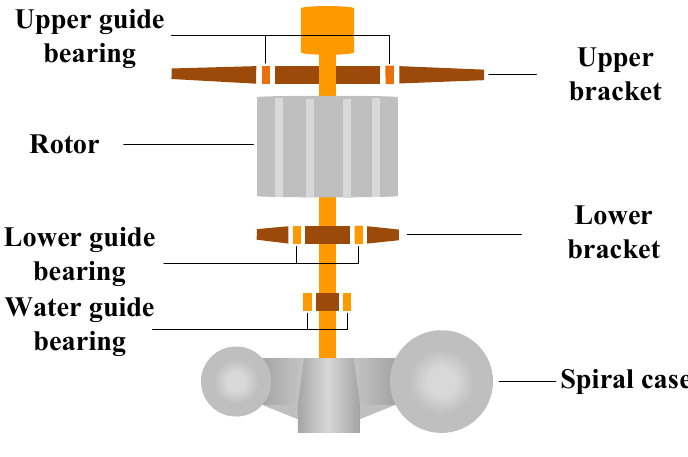
Figure 6. The structure of the PSU.